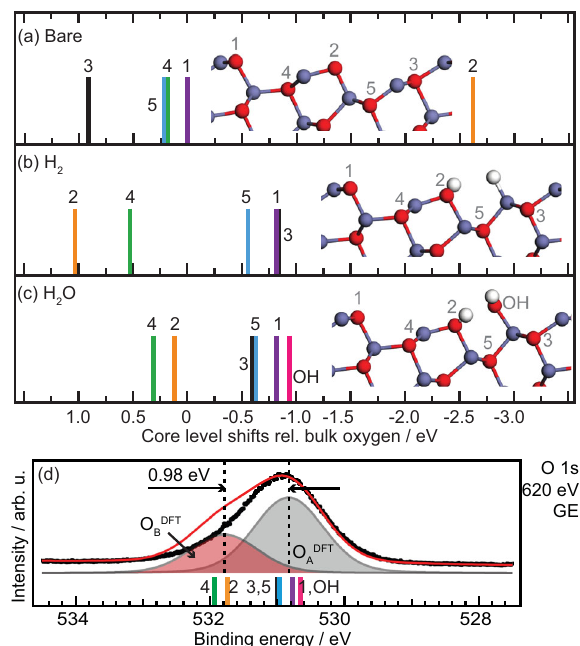
Fig. 4 Calculated O 1s core level shifts of Model A. a Calculated O 1s core level shifts for Model A without adsorbates, b with H 2 -, and c H 2 O adsorbates. Numbers refer to atoms as indicated in the structural models. Atomic colorcode: H (white), O (red), Zn (blue). In both cases the coverage was one molecule per surface unit cell. d Simulated XP-spectra (red line) based on the CLS shown in panel c compared to the measured O 1s in GE (black dots). The measured data is the same as in Fig.